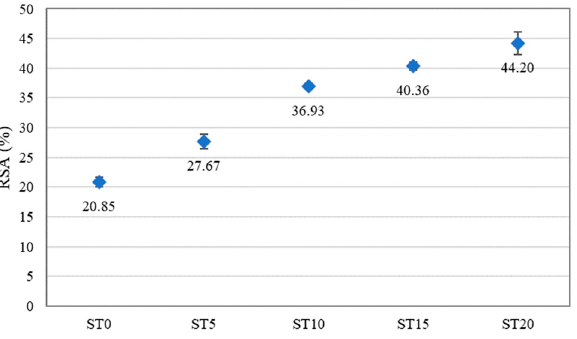
Figure 6. DPPH radical scavenging performance of SPI as well as SPI–BT films.